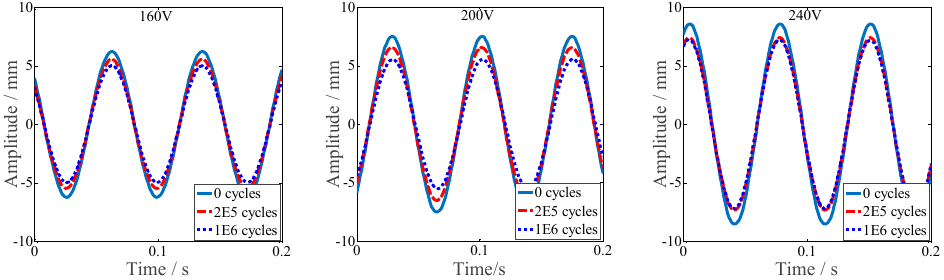
Figure 5. Tip displacement time history of the beam specimen actuated by MFC under cyclic load (stress amplitude 18 MPa).